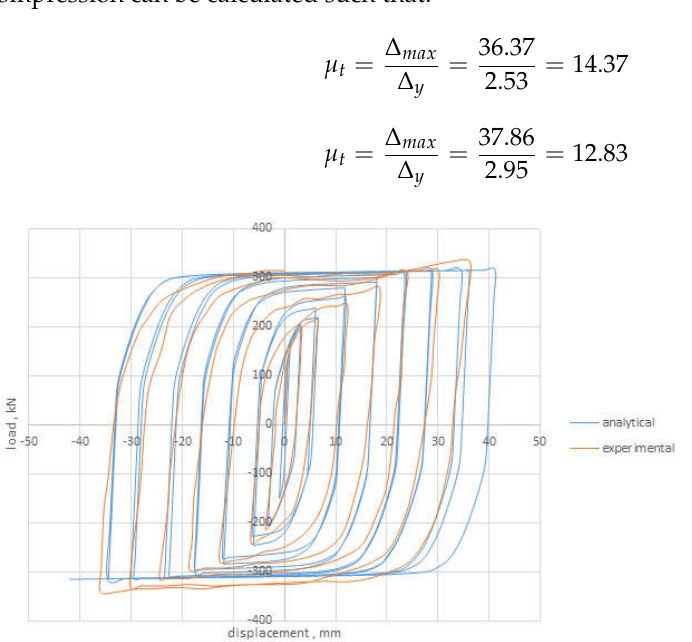
Figure 5. Comparison of load–displacement curve between numerical and experimental models.